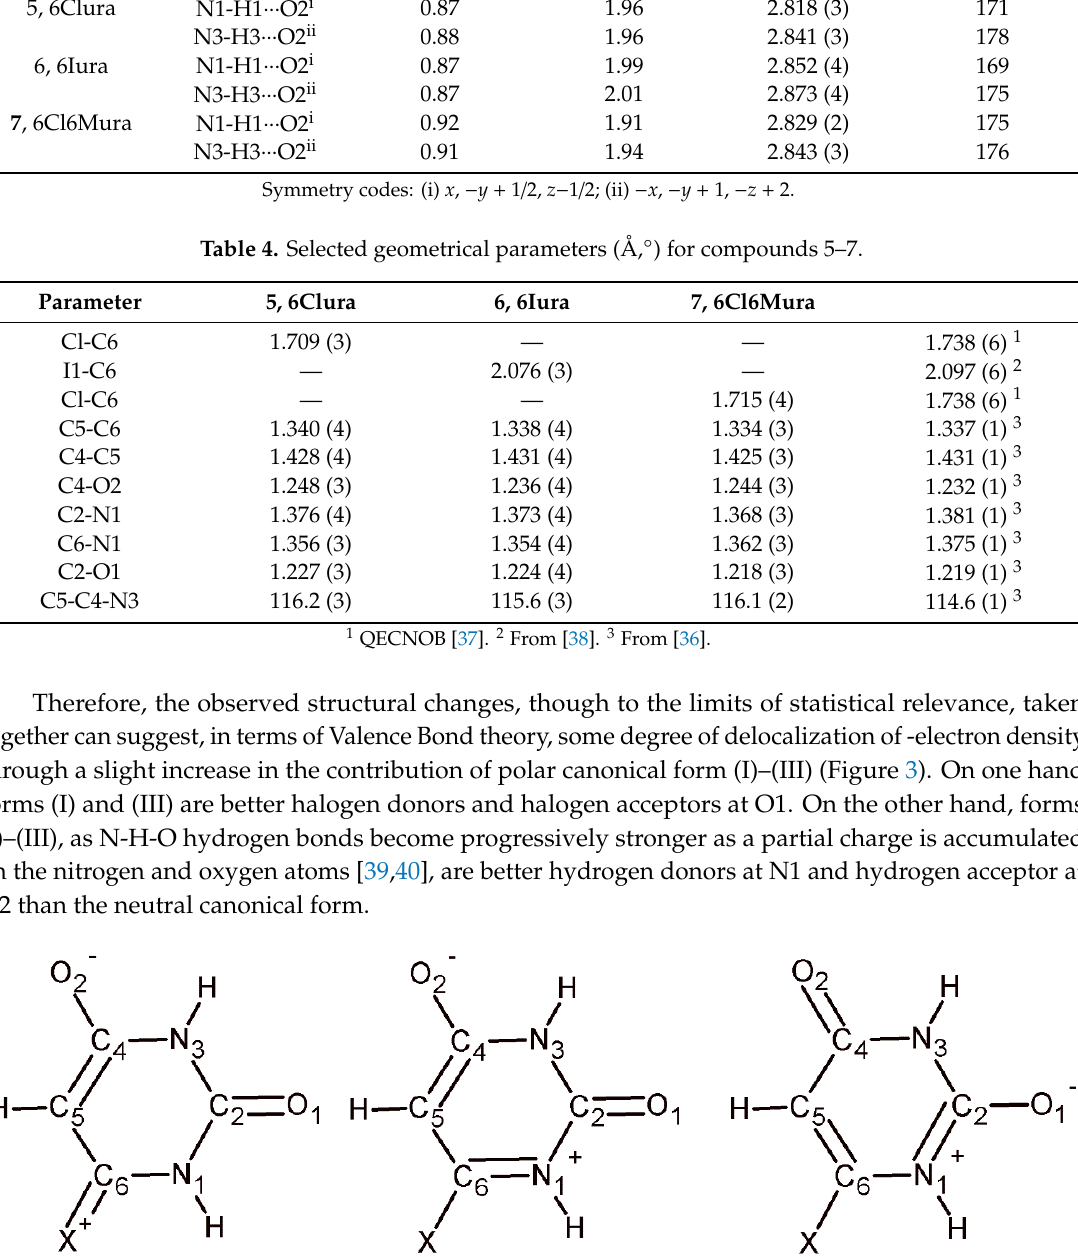
(d) Figure 4. Hirshfeld surfaces mapped on d norm . ( a ) 5Clura; color scale: − 0.619 (red) –0.922 a.u. (blue). ( b ) 5Brura; color scale: − 0.616 (red) –0.950 a.u. (blue). ( c ) 5Cl5Brura; color scale: –0.619 (red) –0.973 a.u. (blue). ( d ) 5Br1Mura; color scale: − 0.601 (red) –0.992 a.u. (blue). As the crystallographic investigation of the 5Clura, 5Brura, and 5Cl5Brura (1, 2 and 3, respectively) showed the crystals to be isostructural in the monoclinic space group P 2 1 / m , the overall two-dimensional fingerprint plot and the plots illustrating close contacts and their proportional contributions will be shown only for 5Clura (Figure 5). For the sake of comparison, contributions of the intermolecular contacts for 5Brura and 5Cl5Brura are summarized in Table 5. The fingerprint plots of all structures show similar features about intermolecular interactions. Long spikes, characteristics for strong hydrogen bonds, for O … H pairwise interaction were found to have similar